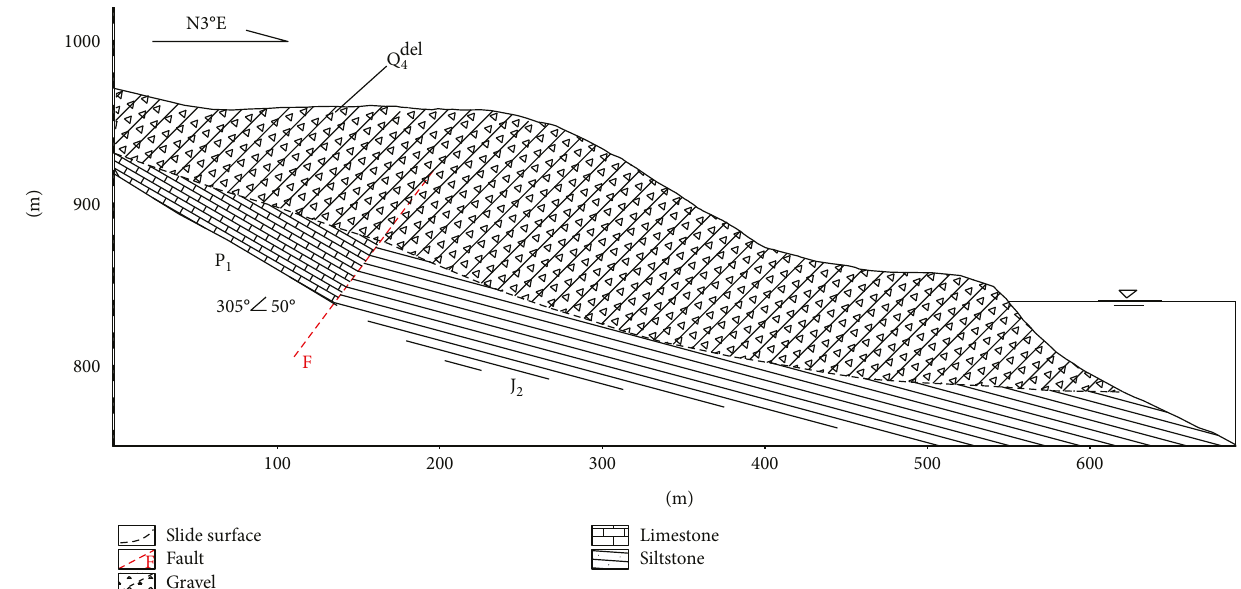
Figure 3: Main geological pro fi le of the Hongyanzi